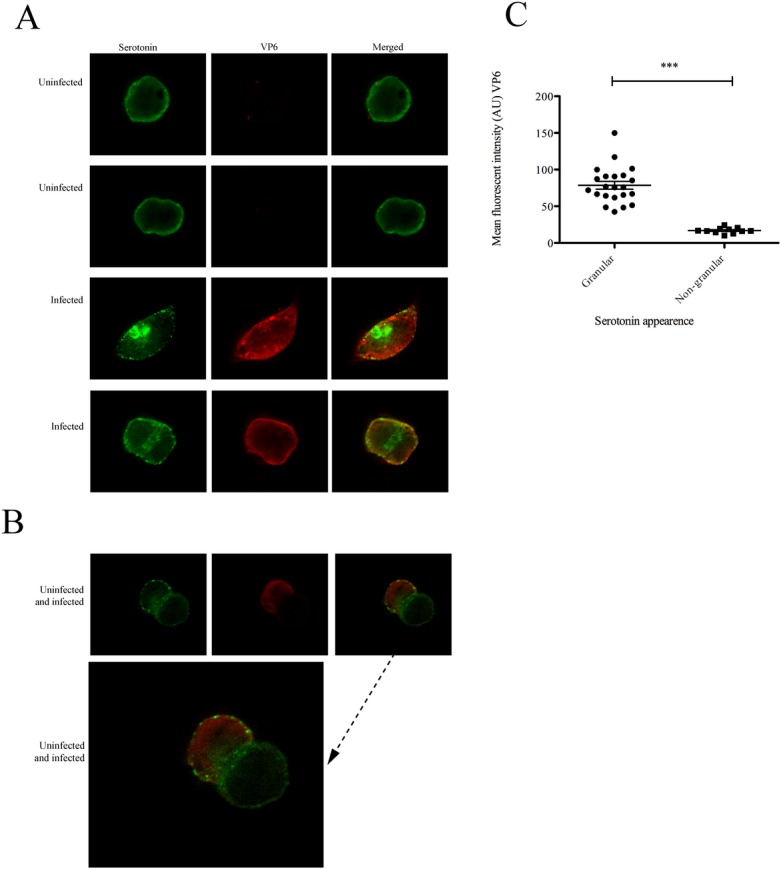
Rotavirus re-organizes serotonin appearance in EC tumor cells.(A) Infected and uninfected cells were co-stained for serotonin (green) and VP6 (red) expression. Infected cells displayed re-organization of serotonin from diffuse cytoplasmic and membrane-associated appearance in uninfected cells to an intense granular membrane-associated appearance in infected cells. (B) Illustration of an uninfected EC cell in close vicinity of an infected cell (red). Note the pronounced granular appearance of serotonin near the plasma membrane of the infected cell. (C) Fluorescent intensity (arbitar units, AU) (VP6) was calculated for each infected (n = 22) and uninfected (n = 13) cell and corresponding appearance (granular vs non-granular) taken into account. Data is presented as means ± SEM. *** = p < 0.001 with Mann-Whitney U test.